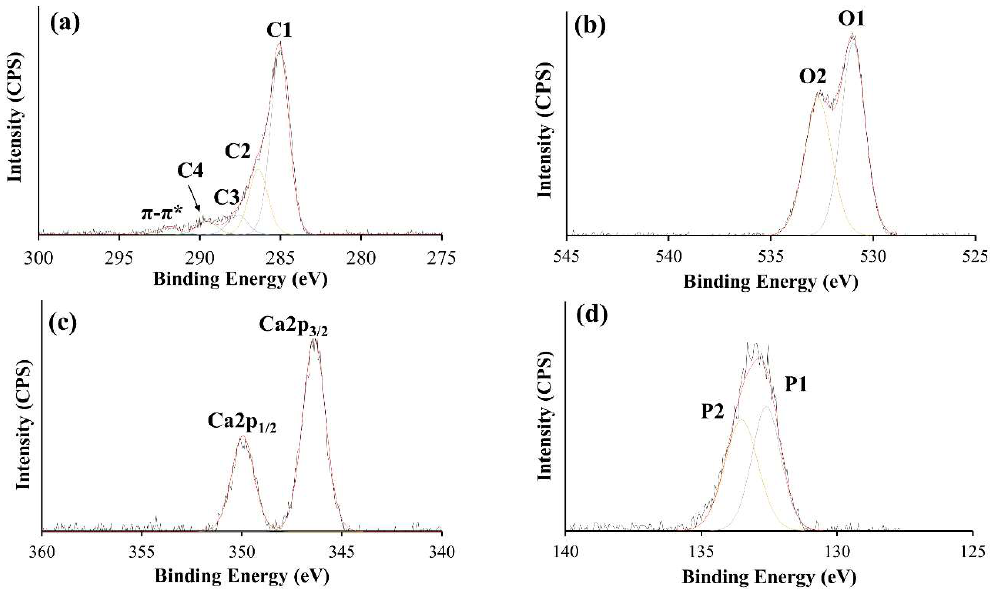
Figure 6. High-resolution peak fitted XPS spectra for the as-deposited HA10 thin film. ( a ) C 1 s , ( b ) O 1 s , ( c ) Ca 2 p , and ( d ) P 2 p .